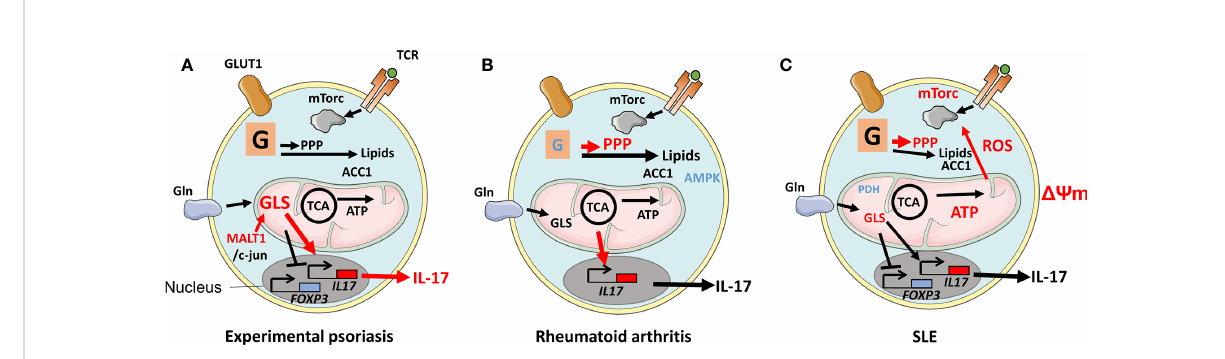
FIGURE 3 Disease-associated changes in metabolic pathways in Th17 cells. (A) During experimental psoriasis, dysregulated expression of Mucosa-associated lymphoid tissue lymphoma translocation protein 1 (MALT1) results in overexpression of Glutaminase 1 (GLS1) and generation of acetyl-CoA from metabolized glutamine. Histone H3K9Ac and H3K27Ac acetylation marks were found in the il17 gene promoter leading to increased IL-17 production and psoriasis. (B) Defective glycolysis and TCA cycle in naive T cells in RA patients and a lack of mechanistic target of rapamycin (mTORC1) restraint due to inactive AMP-activated protein kinase (AMPK) result in an in fl ammatory phenotype with increased migratory properties and the production of IL-17 and IFN g . The metabolism of glutamine in Th17 cells contributes to a Th17 cell phenotype. (C) Th17 cells in patients with SLE are signi fi ed by increased glycolysis and OXPHOS, elongated mitochondria, elevated DY m, and mitochondrial reactive oxygen species (mtROS). The elongation of mitochondria is a consequence of oxidative stress-induced reduction of Rab4A-mediated recycling of Dynamin-related protein 1 (Drp1). Rab4A defect also results in increased mTORC1 activity. Reduced expression of Protein phosphatase 2 (PP2A) results in reduced expression of Pyruvate dehyrogenase 1